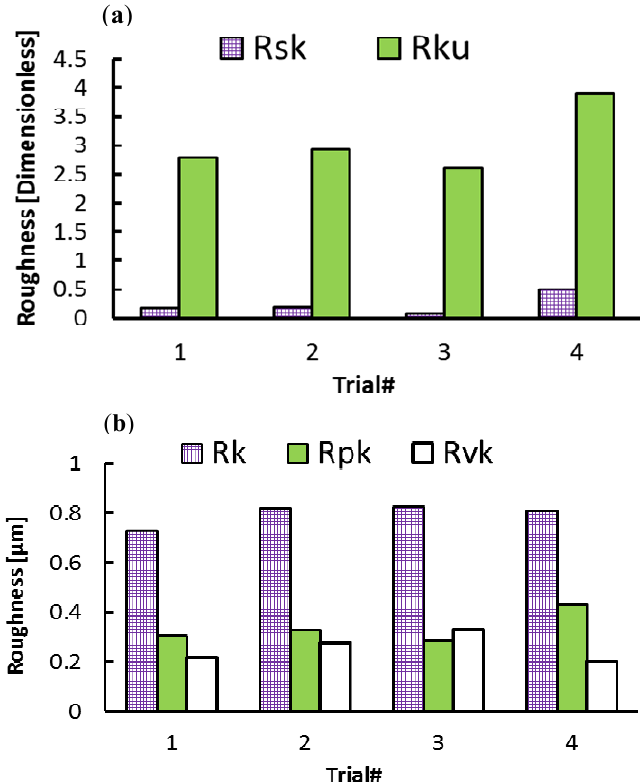
Figure 3. Effect of cutting conditions on amplitude distribution parameters in axial direction. ( a ) Dimensionless parameters; ( b ) dimensional